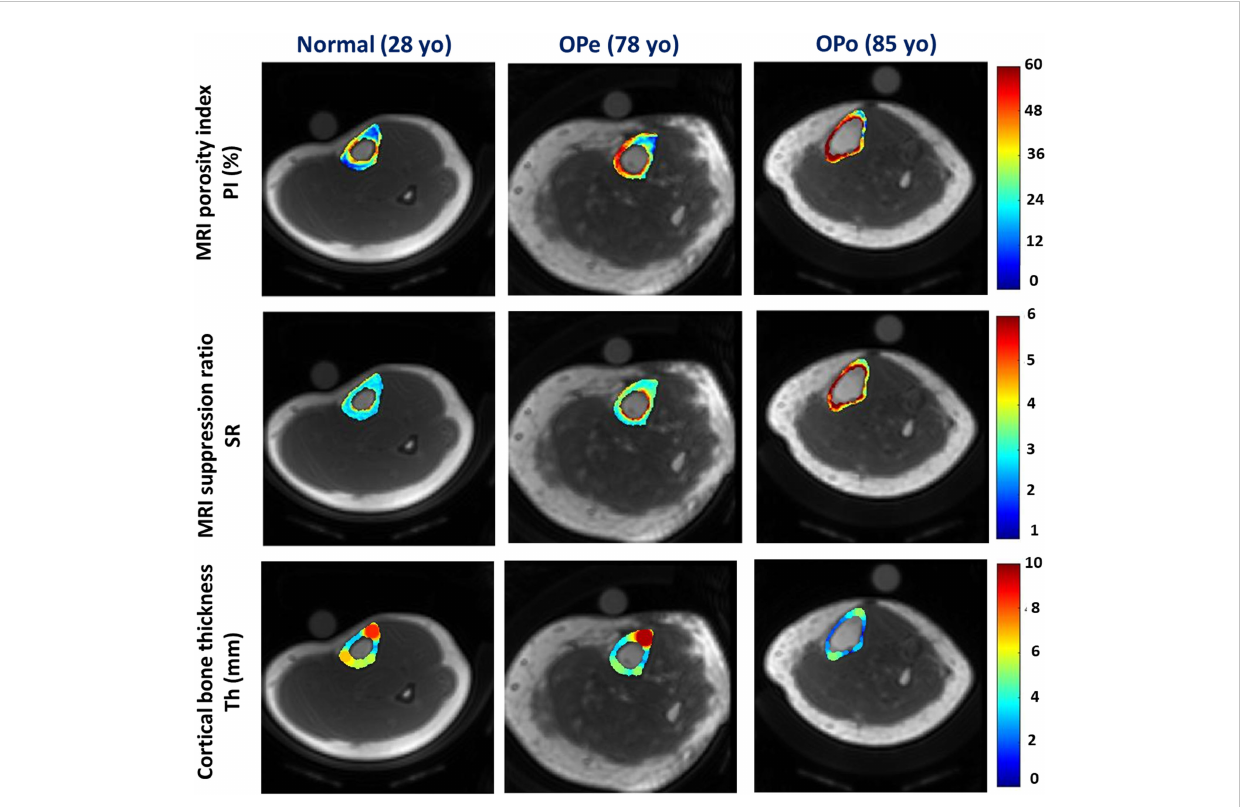
FIGURE 1 Generated PI, SR, and bone thickness maps for exemplary subjects from the Normal group ( fi rst column, 28-year-old female), the OPe group (second column, 78-year-old female), and the OPo group (third column, 85-year-old female). PI and SR were observed in the following ascending order: Normal<OPe<OPo. Regions with higher PI and SR values are likely regions with higher porosity, particularly near the endosteum. In contrast, the mean bone thickness was found in the following descending order: